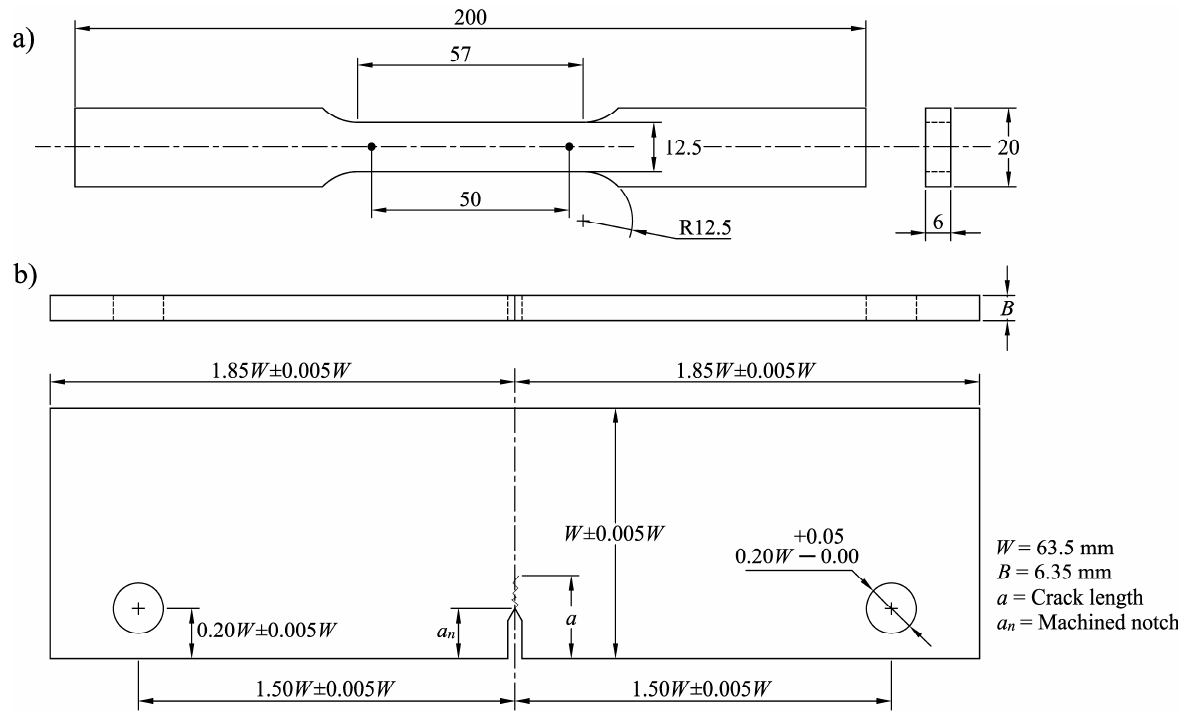
Figure 1. ( a ) Tension test specimen, ( b ) eccentrically loaded single—edge crack tension specimen. Dimensions are in mm.